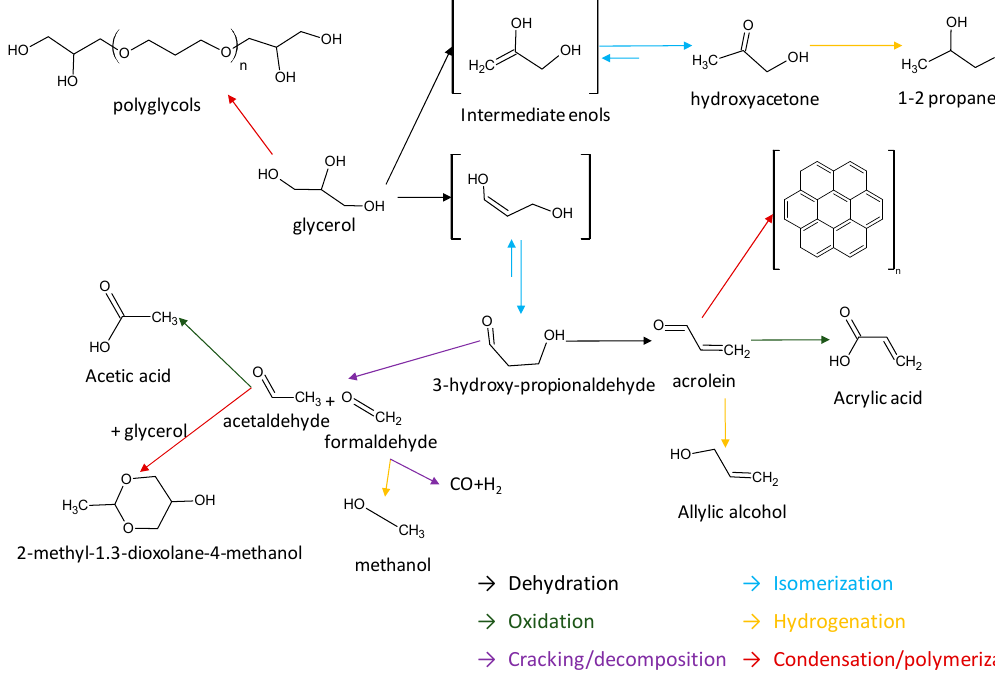
Figure 2. Reaction scheme of glycerol dehydration (derived from References [47,48]).